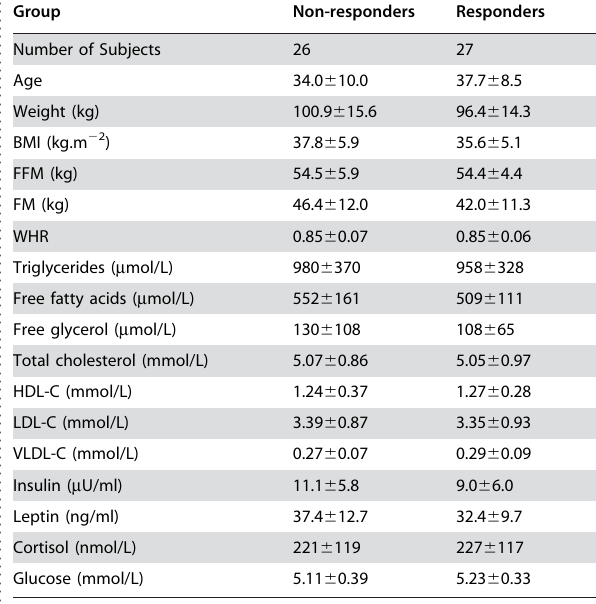
Table 1. Baseline characteristics of responders (8–12 kgs weight loss) and non-responders ( , 4 kgs weight loss) at T0. .. ... .... ... ... .... ... ... .... ... ... .... ... ... .... ... ... .... ... ... ....